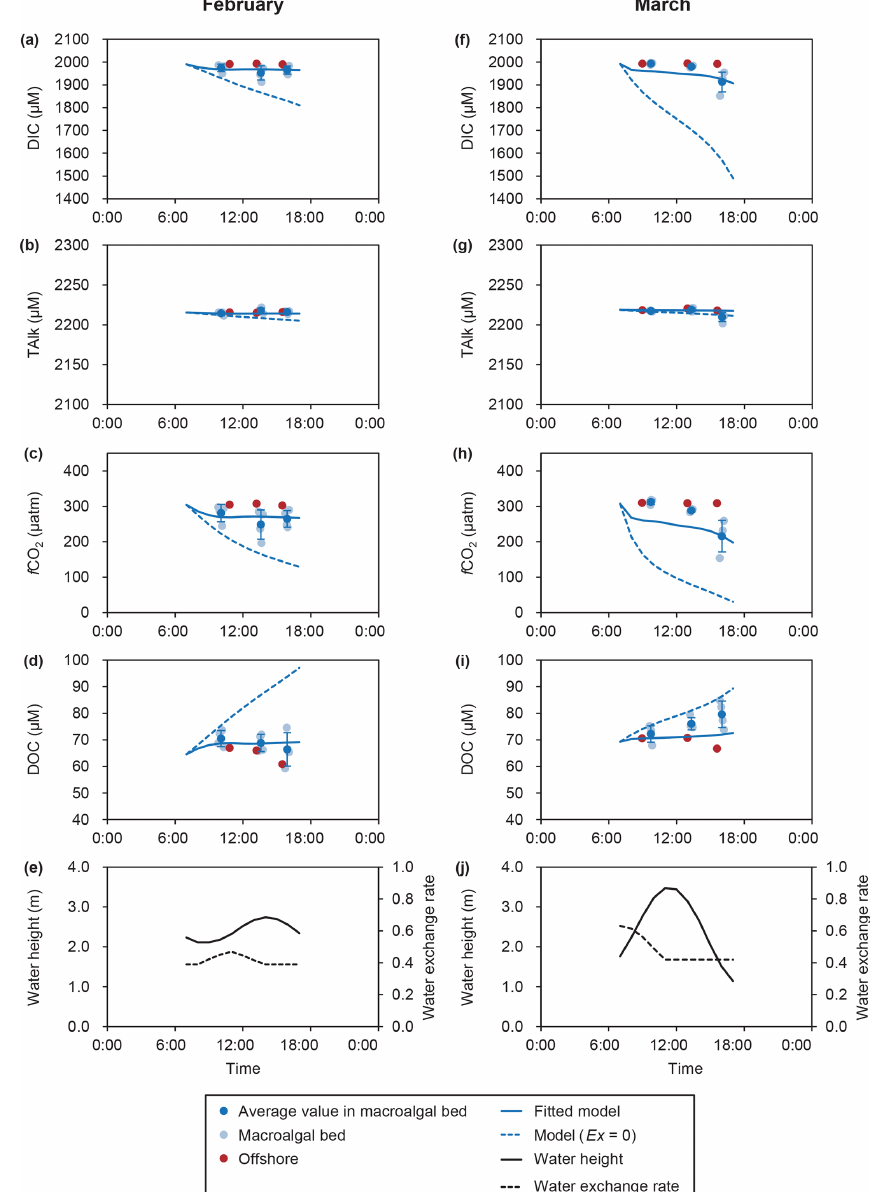
Figure 3. Temporal changes in dissolved inorganic carbon (DIC), total alkalinity (TAlk), fugacity of CO 2 ( f CO 2 ), dissolved organic carbon (DOC), water height, and water exchange rate (EX) in February (a–e) and March (f–j) . Modeled values of chemical parameters were estimated by using mass-balance models. Error bars show standard deviations. Blue dashed lines show the model results if the EX is zero. Details regarding observed values are provided in Table